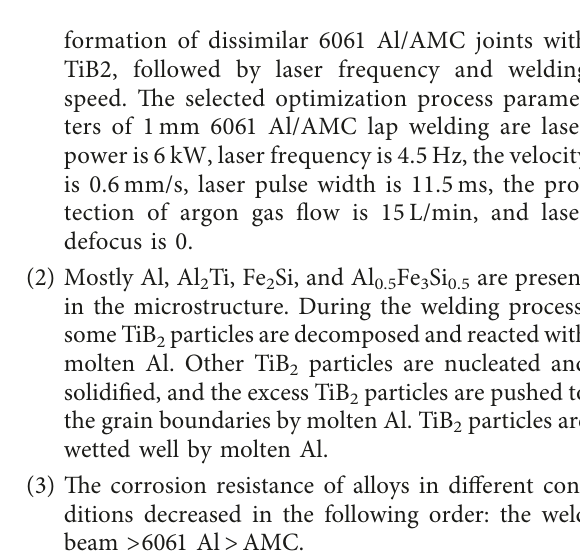
2 phase retarding